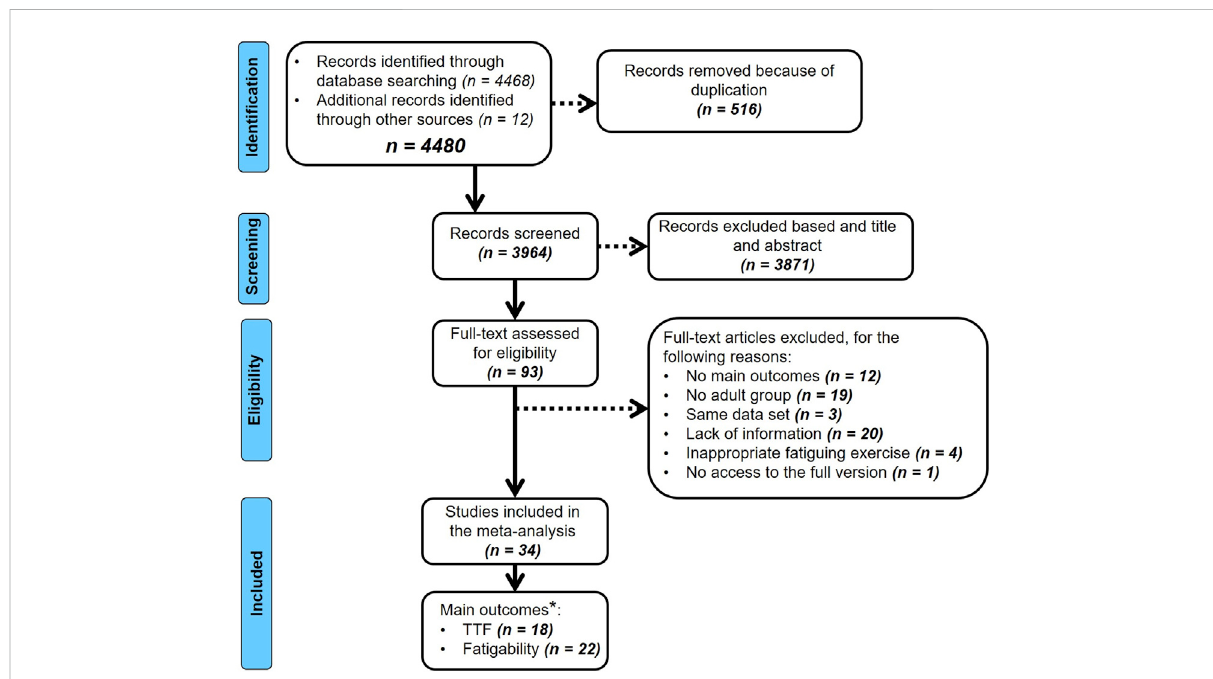
FIGURE 1 PRISMA fl owchart of included studies. *Some articles investigated TTF and fatigability in the same experimental design and were included in both